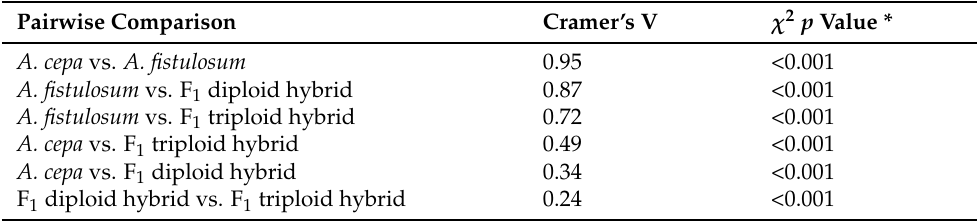
Table 2. Pairwise comparisons of chiasmata type distribution in A. cepa , A. fistulosum , and the F 1 diploid and triploid hybrids ( A. cepa × A. fistulosum